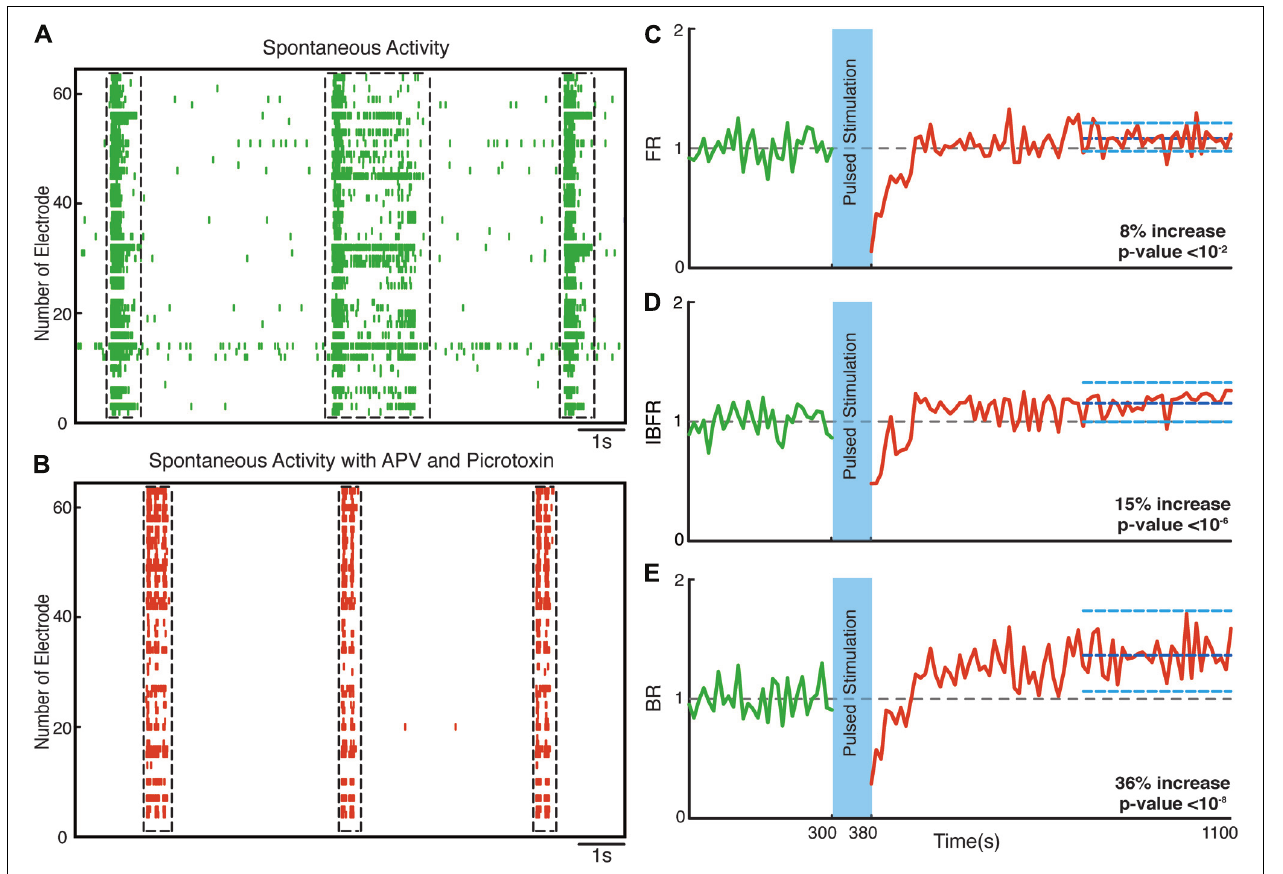
FIGURE 8 | Network plasticity in the presence of APV/Picrotoxin. (A,B) Spontaneous activity (before stimulation) of a neuronal culture before and after adding APV/Picrotoxin. (C) Average normalized FR before and after stimulation Here and in the other panels, the dotted gray line marks the mean before stimulation and the dark blue line marks the mean after stimulation. (D) Normalized average IBFR. (E) Normalized average burst